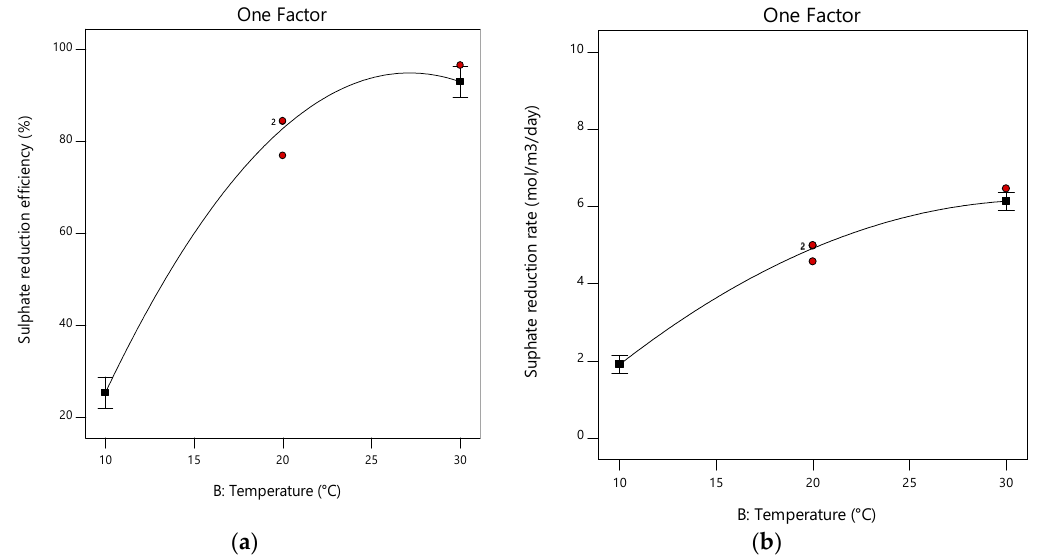
Figure 7. Temperature effect on ( a ) sulphate reduction efficiency and ( b ) sulphate reduction rate at pH 5 and HRT of 4.5 days.